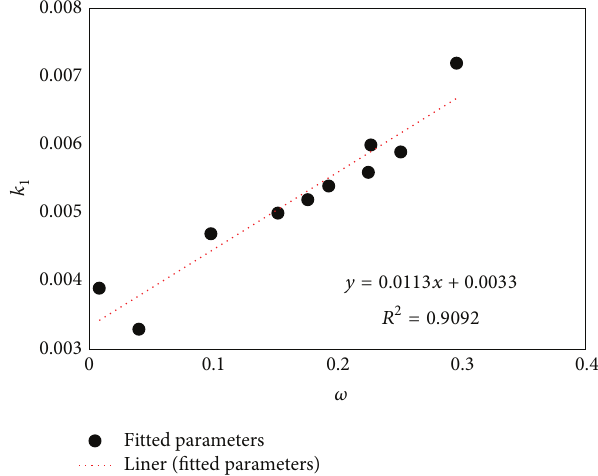
Figure 1: Linear trend of fitted parameter 𝑘 1 of the 𝛼 -function equation (3).